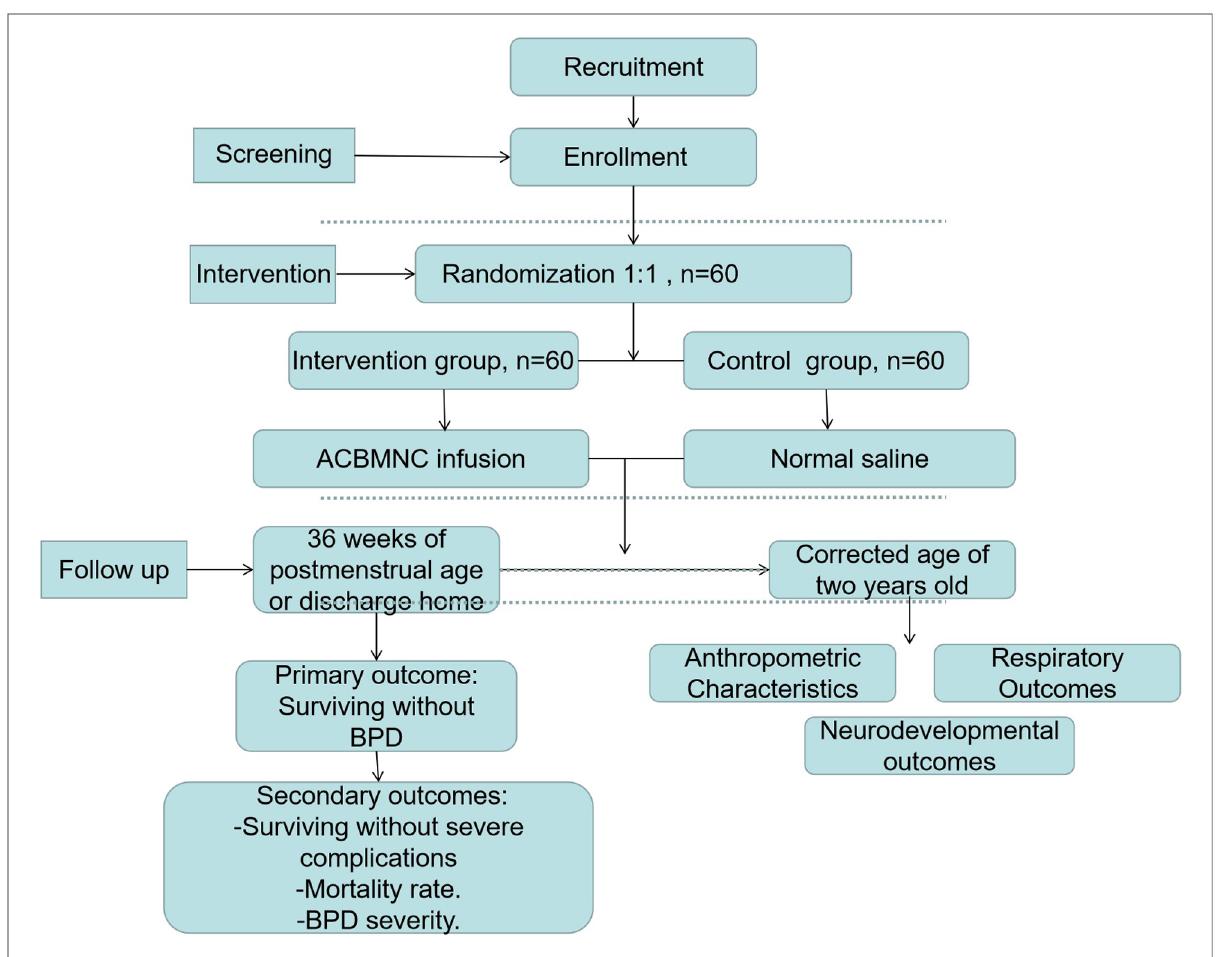
FIGURE 1 Consort fl ow